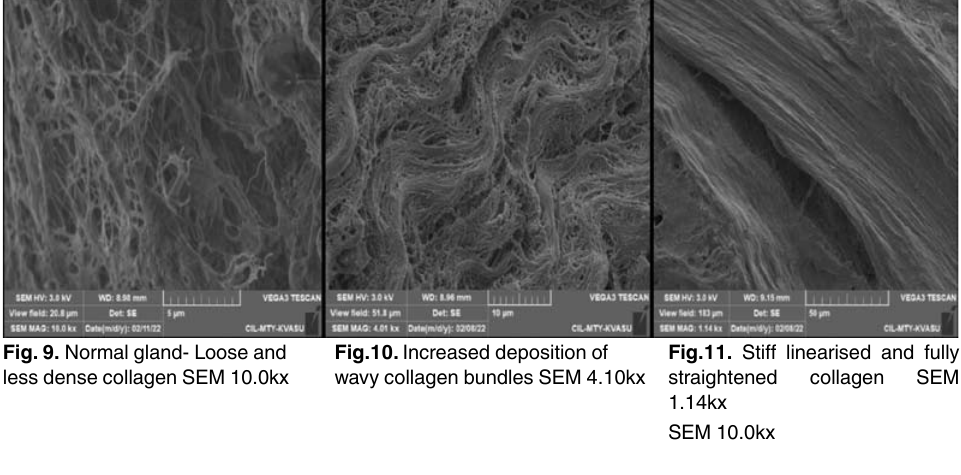
Fig. 9. Normal gland- Loose and less dense collagen SEM